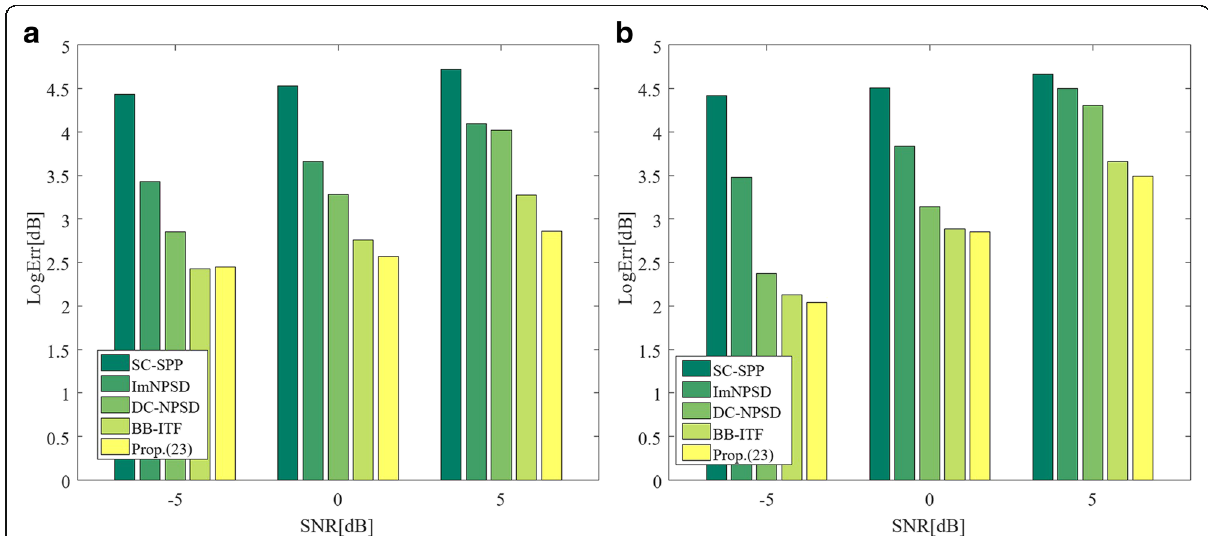
Fig. 9 Averaged LogErrs measured for a speech source at a 0° and b − 90°